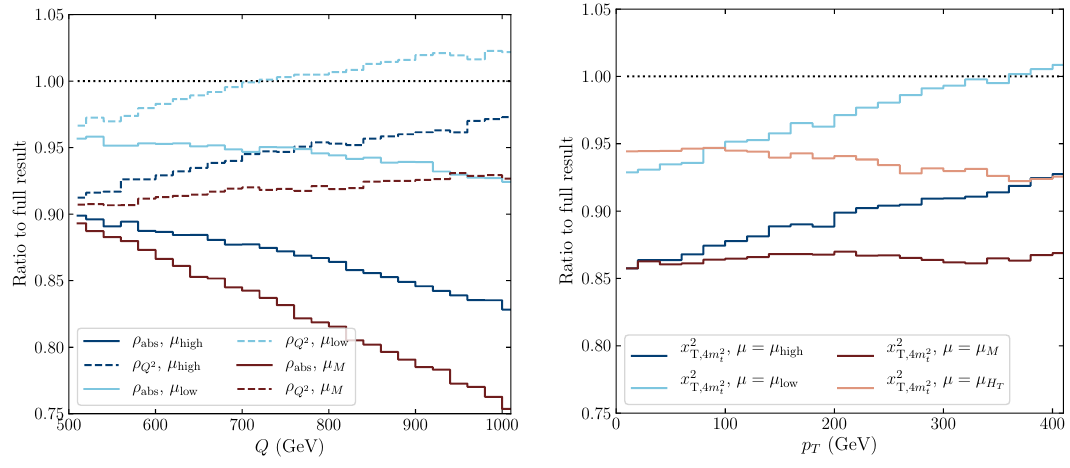
Figure 11 . Left: the NLL distributions for the ratio between the invariant-mass distribution obtained by setting λ = λ and the full result. The solid (dashed) lines indicate using the 0 threshold definition ρ ( ρ ), while the dark-blue/light-blue/red lines represent the results using abs Q 2 µ high / µ low / µ M . Right: the NLL distributions for the ratio between the transverse-mass distribution obtained by setting λ = λ and the full result. We used x 2 as our threshold variable, and the 0 T, 4 m 2 t color indicates the scale choice: µ (dark blue), µ (light blue), µ (red), or µ (orange). high low M H T